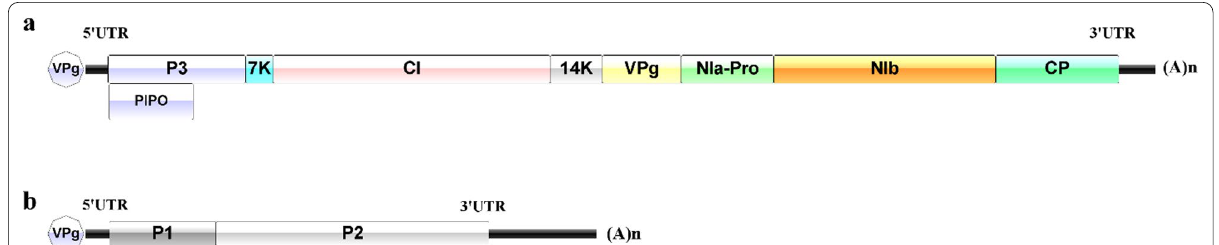
Fig. 3 Schematic diagram of the gene expression strategy and genomic organization of wheat yellow mosaic virus (WYMV). a RNA 1 of WYMV. A single large polyprotein is cleaved into the eight mature proteins shown within the smaller boxes that make up the ORF. P3N-PIPO derives from frameshifting of the P3 protein, and (A)n represents the poly(A) tail. 7 K, 7-kDa peptide; CI, cylindrical inclusion protein; 14 K, 14-kDa peptide; VPg, viral protein genome-linked; NIa-Pro, nuclear inclusion a-protease; NIb, nuclear inclusion b; CP, coat protein. b RNA 2 of WYMV. A single large polyprotein is cleaved into the two mature proteins, P1 protein and P2 protein, shown within the smaller boxes that make up the